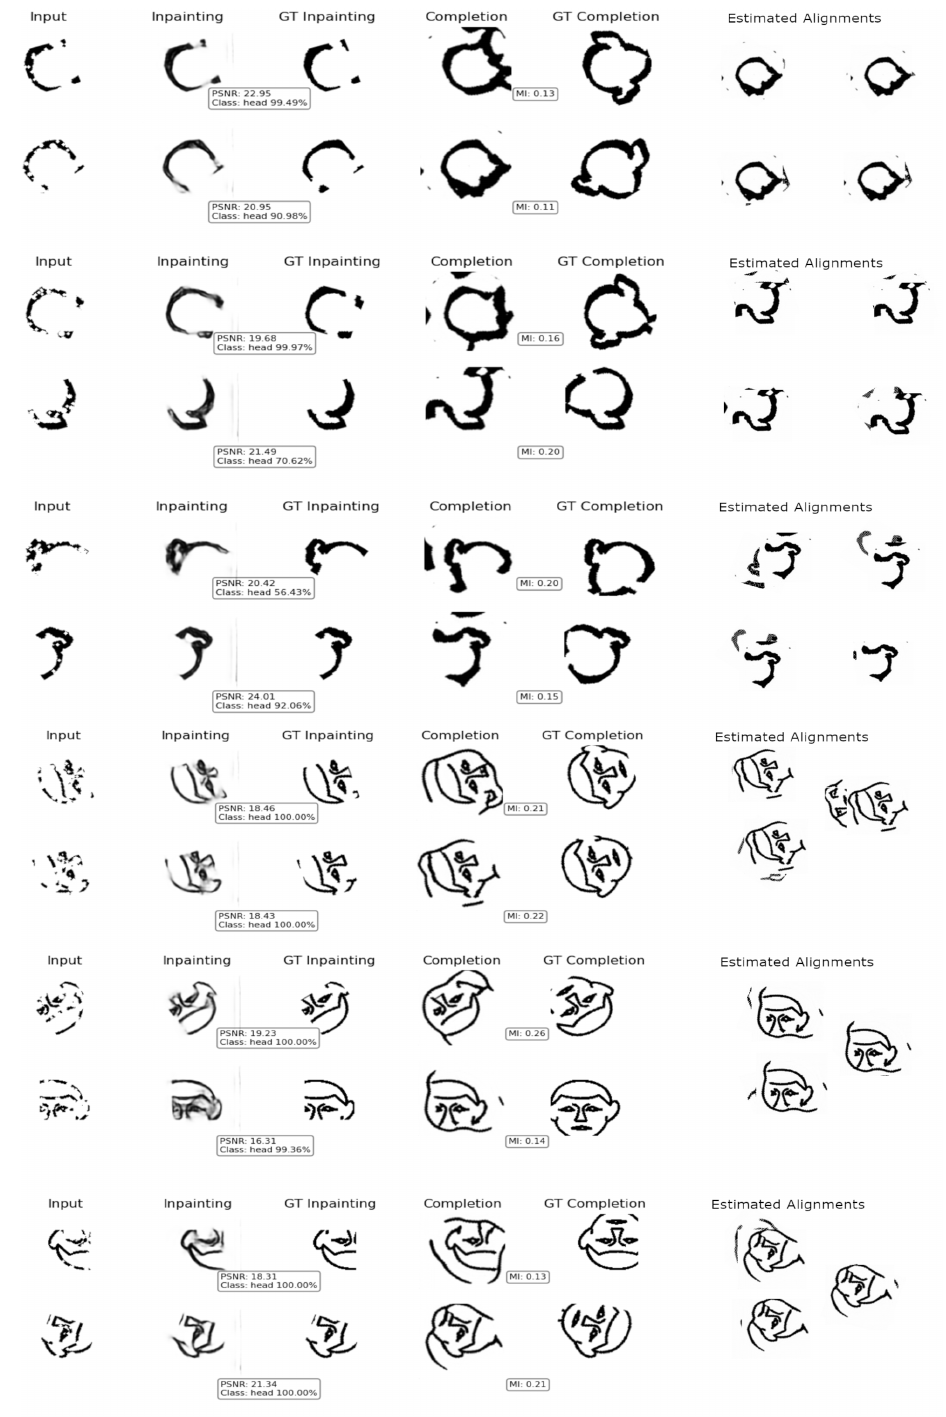
Figure 19. Examples of obtained results for the head sign. From inpainting to registration. Figures 18 and 19 show the results for the circle and head signs, respectively. They are analyzed together since they exhibit similar registration results. As with previous signs, the inpainting model successfully fills the line and curve gaps. Consequently, the obtained classification score is over 90% for all input drawing segments. The main issue for this sign lies in the decoration completion module. When a straight line is expected to extend a drawing trace, the model attempts to complete it with a circular shape. This problem negatively affects the MI-based registration approach, as incorrectly